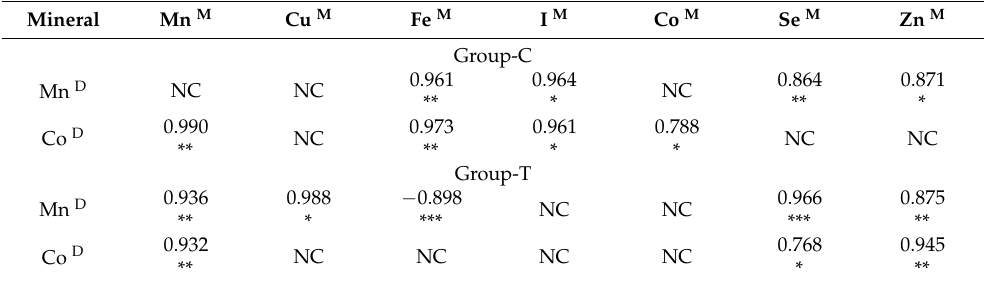
Table 7. Correlation coefficient of some trace elements for female camels’ blood serum and milk. Mineral Mn M